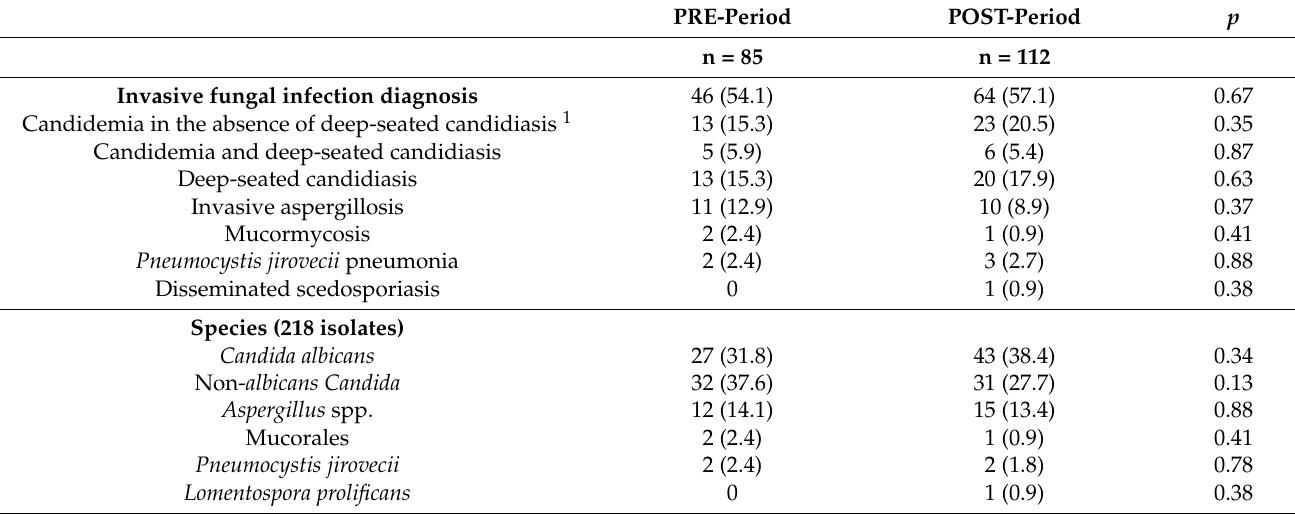
Table 3. Description of invasive fungal